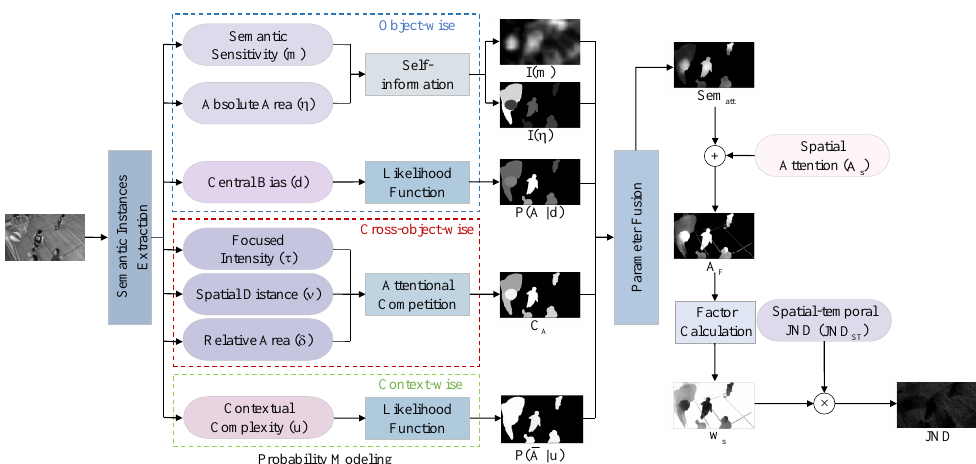
Figure 11. A briefoverview of the proposed spatio-temporal JND